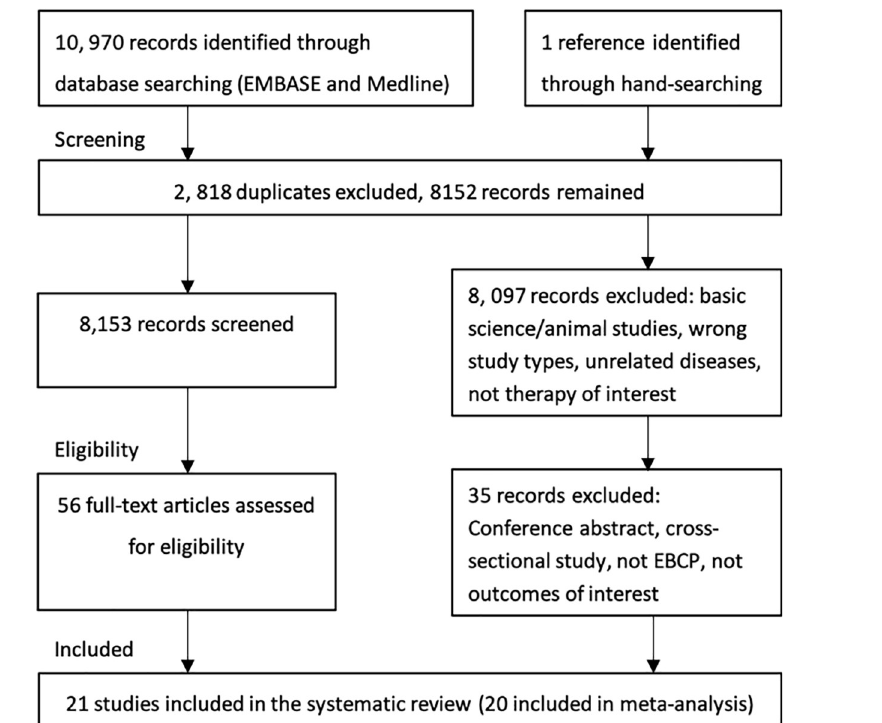
Fig 1. PRISMA flow chart summarising study identification and